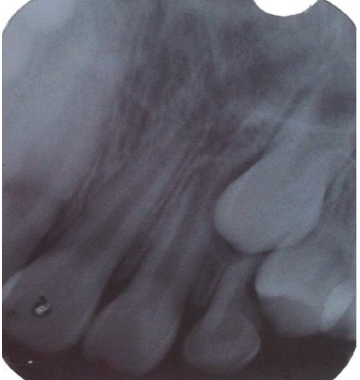
Figure 2: Radiographic aspect of the lesion without signs of abnor- mality.